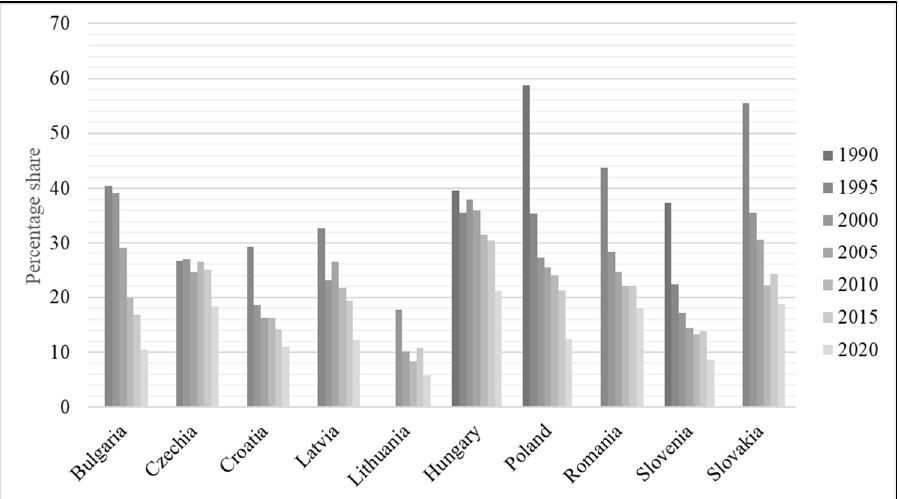
Figure 6. Passenger transport by public transport (trains, motor coaches, buses, and trolley buses) [55]. Data on public mass transit passenger transport between 1990 and 2020 was analyzed. Passenger transport by public transport in CEE countries has been steadily declining. During the